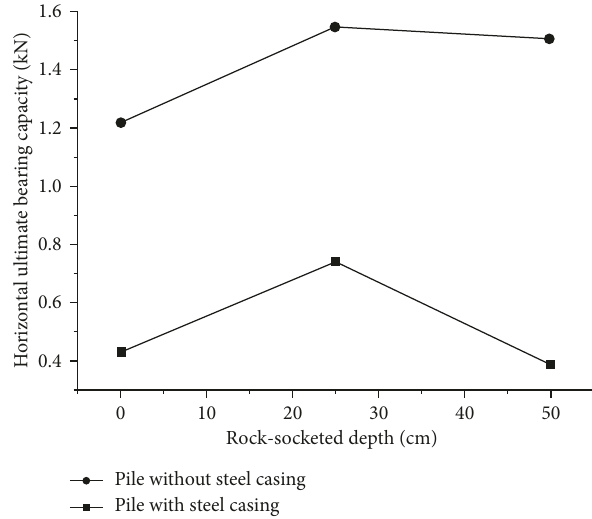
Figure 18: Horizontal ultimate bearing capacity of the rock- socketed piles under different depths of rock